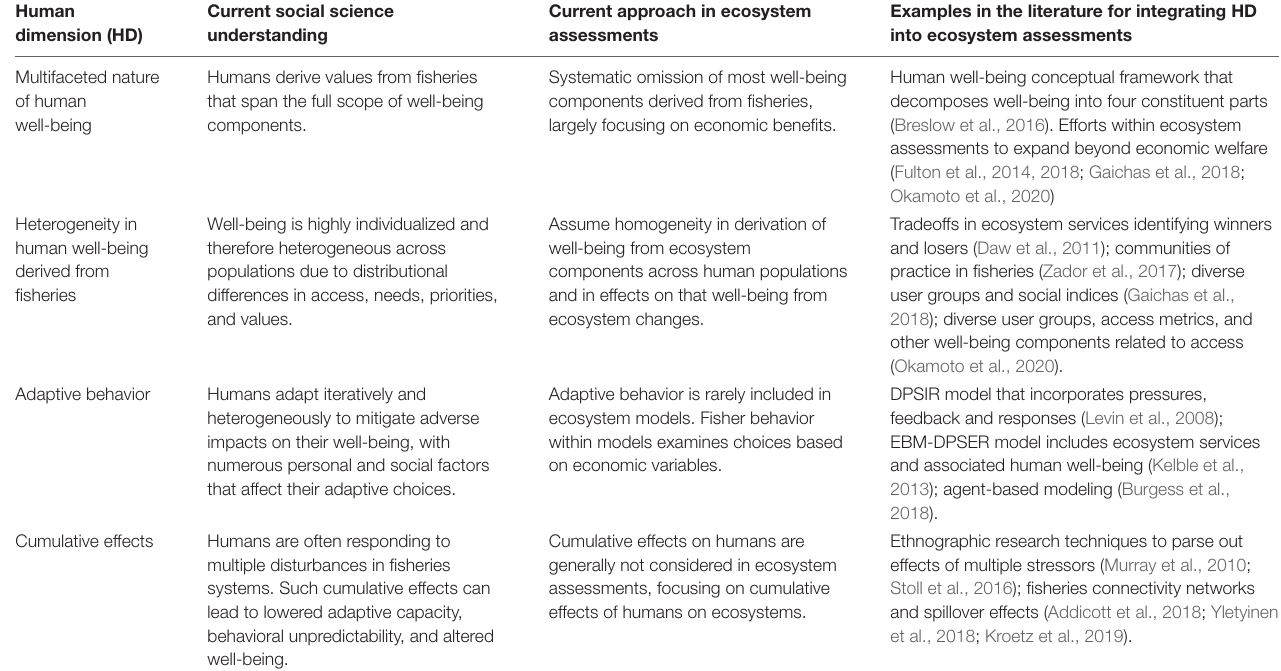
TABLE 1 | Key human dimensions for inclusion in ecosystem assessments. Human dimension